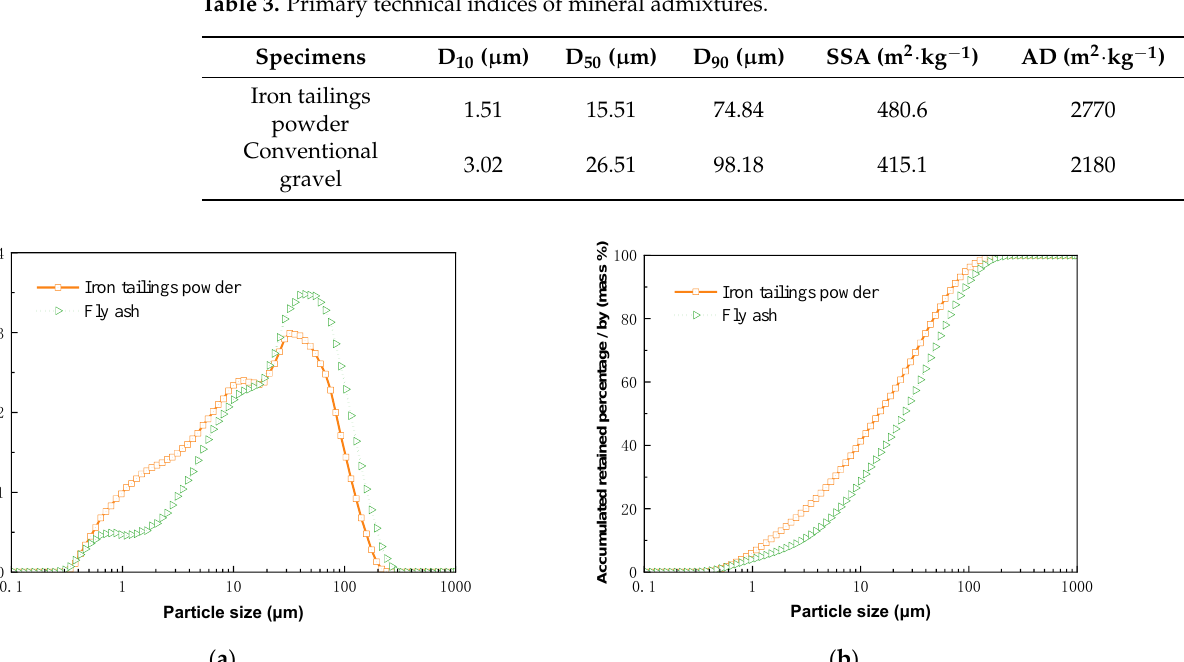
Figure 4. SEM micrograph at 4000× magnification of particles: ( a ) cement; ( b ) iron tailings; ( c ) fly ash. Table 3. Primary technical indices of mineral admixtures.